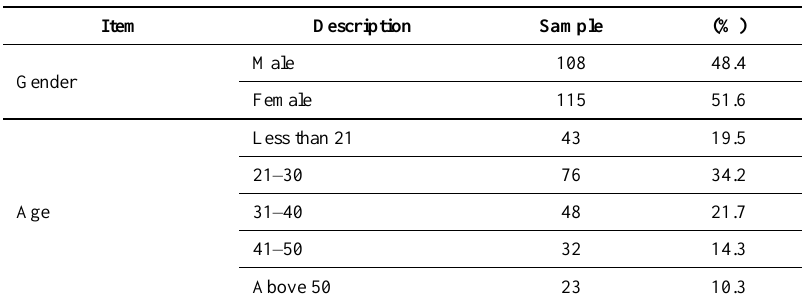
Table 2. Demographic